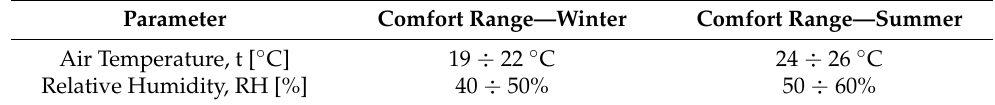
Table 5. Typical thermal comfort parameters.